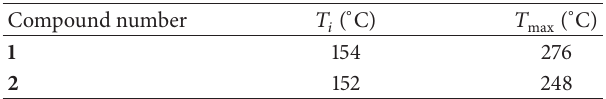
Table 1: Initial ( 𝑇 𝑖 ) and maximum ( 𝑇 for the thermal degradation of the